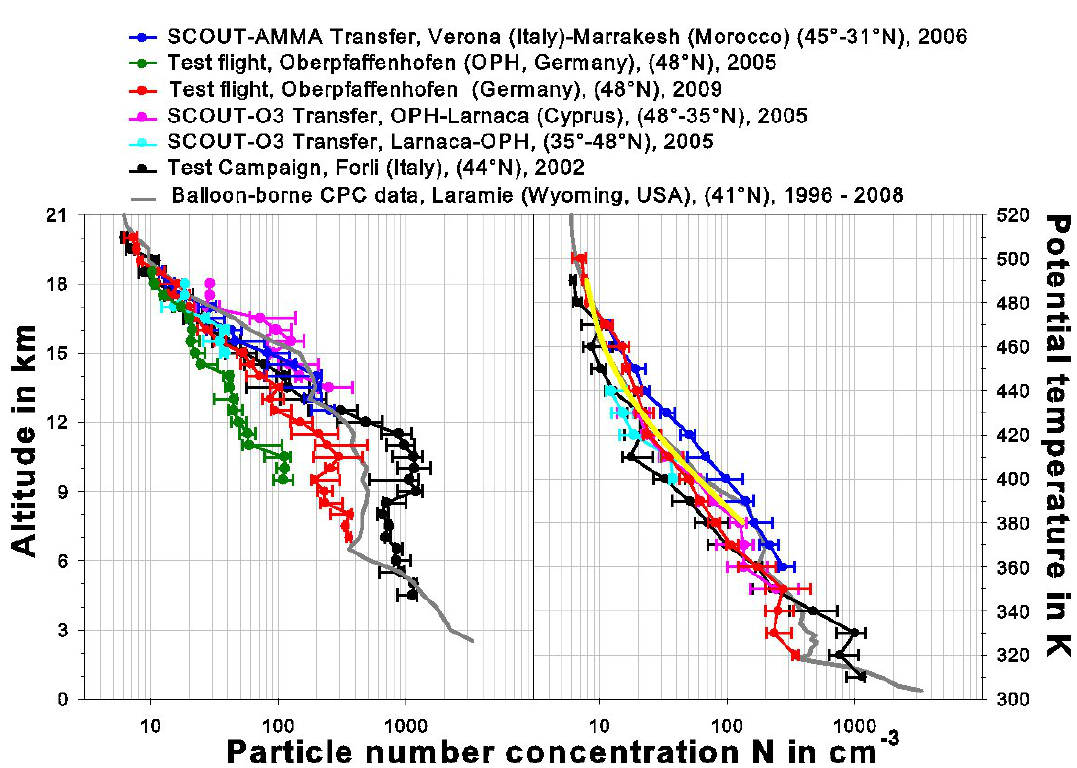
Fig. 9. Mid-latitude vertical profiles of COPAS particle number densities ( N 10 ) from the M-55 “Geophysica” flights between 2002 and 2006 (as medians of 10K altitude bins and 25%, 75% percentiles). The grey line is an average profile from balloon borne CPC measurements of the University of Wyoming from 1996 until 2008. The yellow curve is the parameterisation of Eq. (2) as derived from the 380K to 490K data of this panel (note: The left and right ordinates do not correspond to each